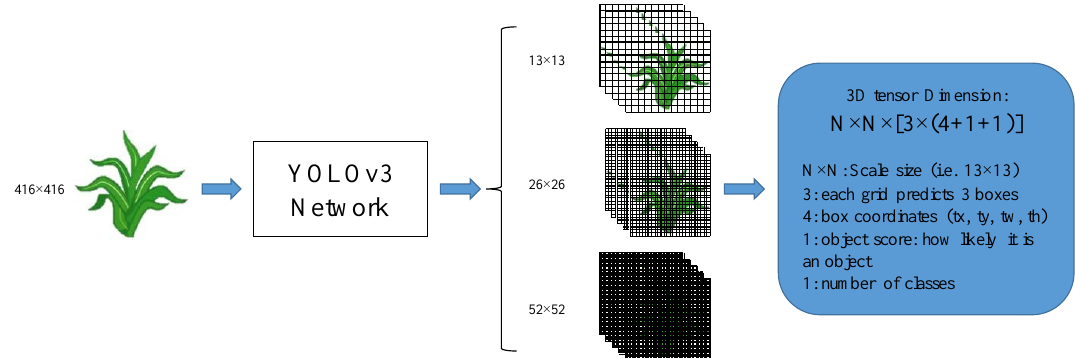
Figure 4. YOLOv3–tiny detection architecture.